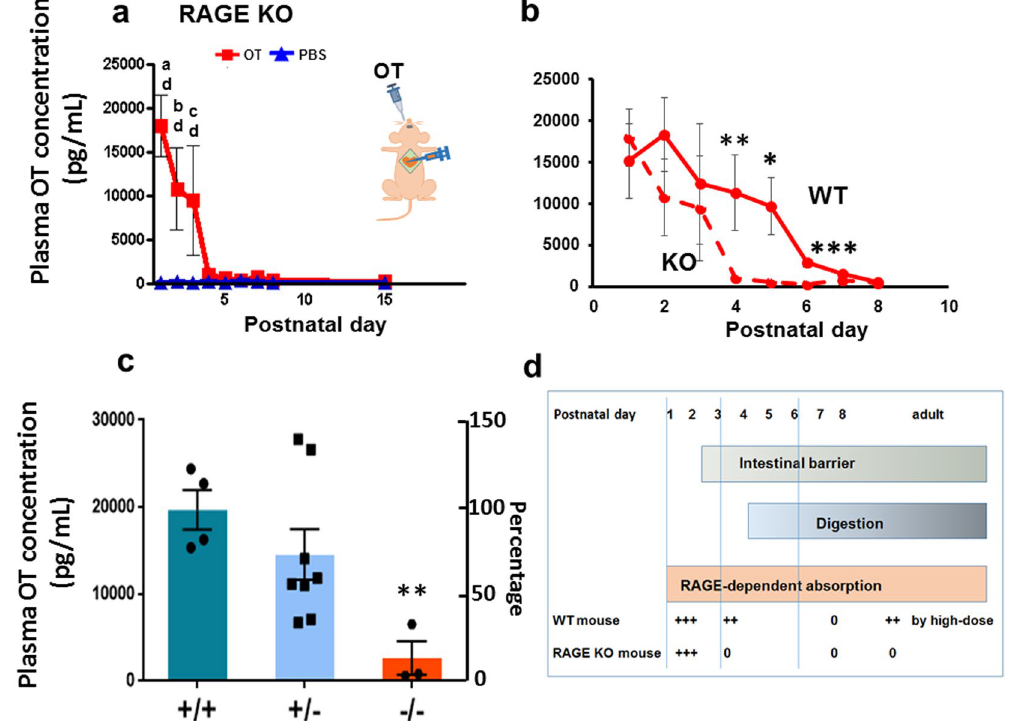
Figure 3. Plasma OT concentrations in Ager − / − (RAGE KO) mice. ( a ) Time course of plasma OT levels in pups 10 min after the oral administration of 1 μ g of OT/mouse (squares; 100 μ M × 10 μ L) or saline (triangles; 10 μ L). Blood samples were collected from the hearts of male and female pups at the indicated postnatal days. Inset indicates oral OT delivery and blood collection from the heart. The number of experiments was 3–15 for OT and 3 for saline. Two-way ANOVA, F 8,90 = 5.16, P < 0.001. Bonferroni’s post hoc tests showed significant differences between OT and PBS ( d P < 0.001) or OT and PNDs, as indicated ( a P < 0.001, b P < 0.01, c P < 0.05 from PND8). ( b ) Plasma OT levels in wild-type and RAGE KO pups 10 min after oral administration of OT. The data are re-plotted from Figs 1b and 3a. Two-way ANOVA, F 1,126 = 4.73, P < 0.05. Bonferroni’s post hoc tests showed significant differences between wild-type and RAGE KO mice at * P < 0.05, ** P < 0.01, and *** P < 0.001. ( c ) Plasma OT concentrations in Ager + / + (n = 4), Ager + / − (n = 8) and Ager − / − (n = 3) pups